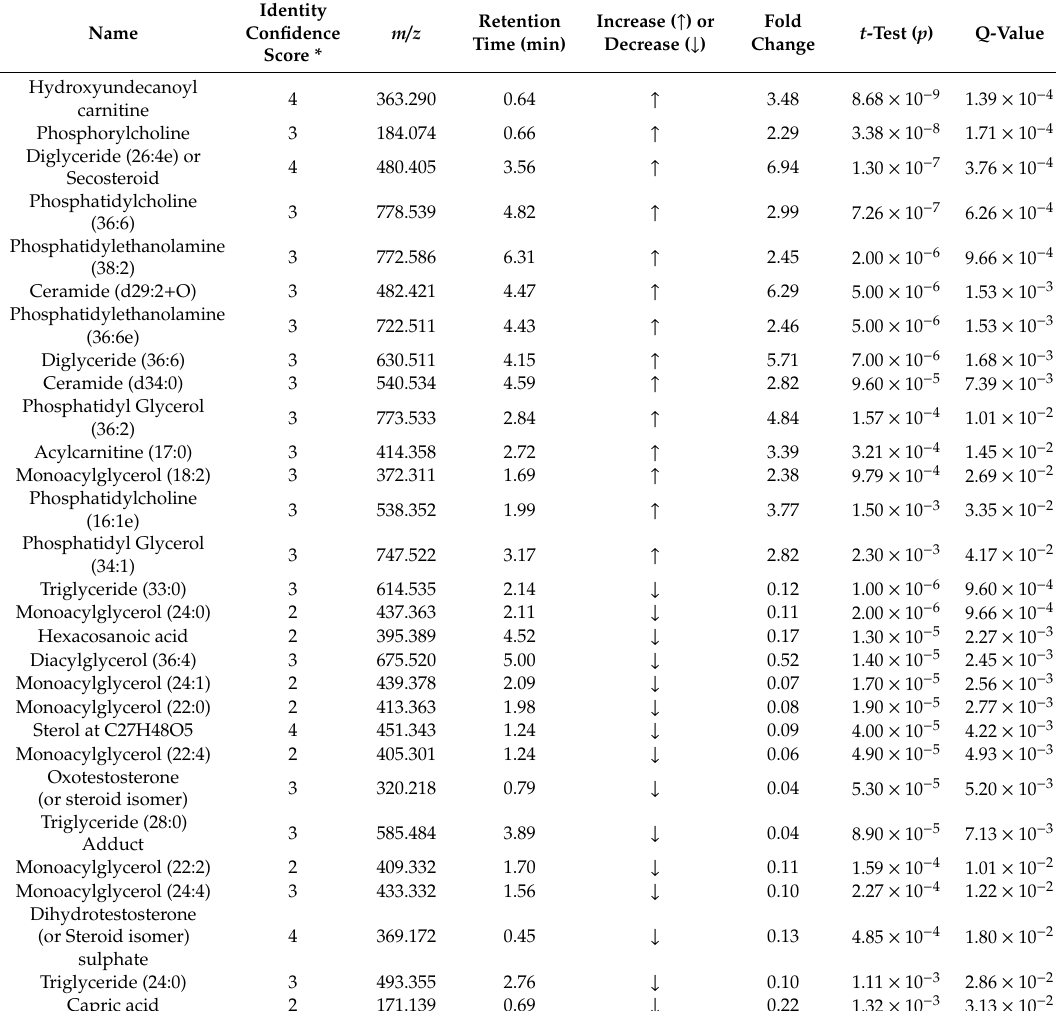
Table 3. Significantly changed lipid compounds that decreased or increased between endometrial cancer and control (tissue samples). * Metabolite identification confidence score as described elsewhere